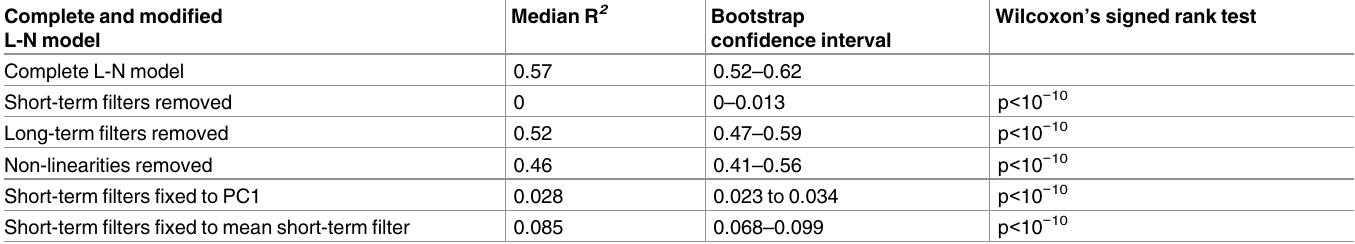
Table 1. Coefficients of determination R 2 between predictions and measuredfiring rates for the L-N model used in this work and severalmodified L-N models. All modification of the model significantly decreasedits performance in predictingfiring rates (Wilcoxon’s signedrank tests). Complete and modified L-N